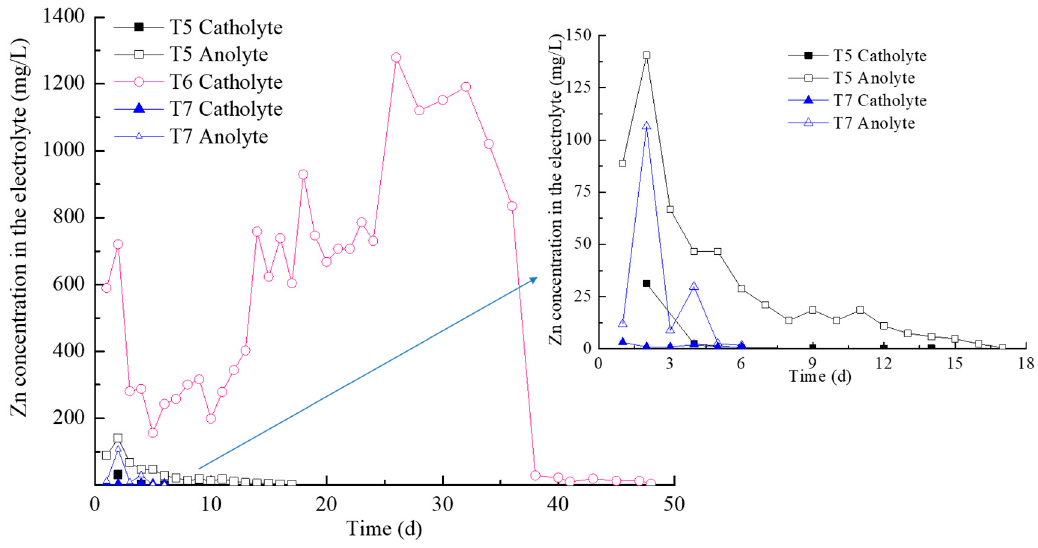
Figure 4. Zn concentration in the electrolytes of T5, T6, and T7.